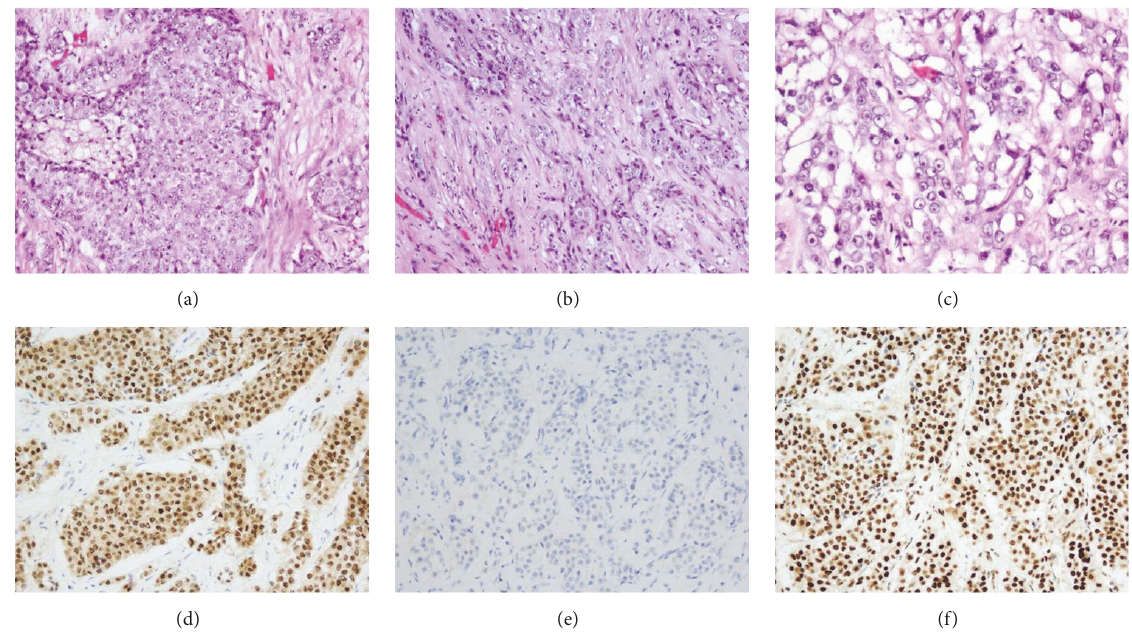
Figure 2: Histologic and immunophenotypic features of collecting duct carcinoma. (a) Tumor cells form solid sheets (20x). (b) Linear and single cell infiltration (20x). (c) Prominent large nucleoli (40x). (d) Positive for PAX8, consistent with renal origin. (e) Negative for GATA-3, ruled out urothelial origin. (f) INI-1 retained, ruled out medullary